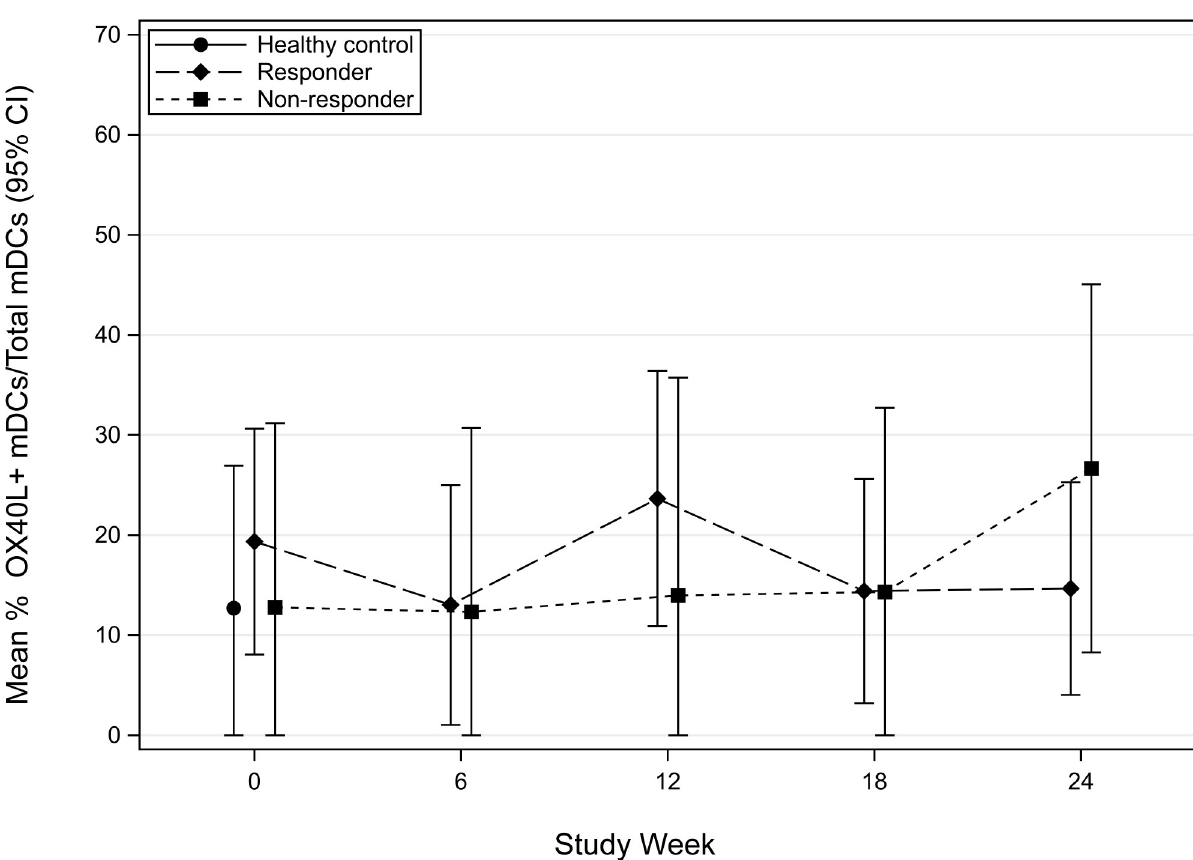
Fig 6. Mean percent frequency (95% CI) of OX40L myeloid dendritic cells (mDCs) following CPE stimulation in the 1 st 24-weeks in POIT responders and non-responders.